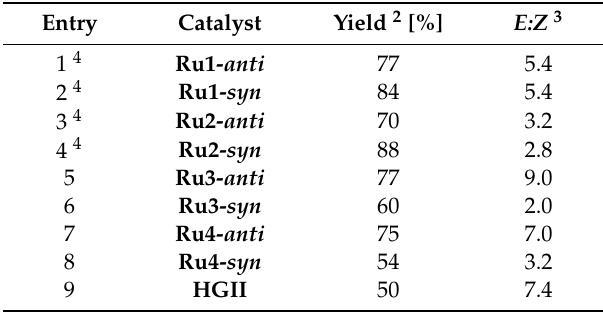
Table 3. CM of 3 with 4 in the presence of Ru1 – Ru4 and HGII 1